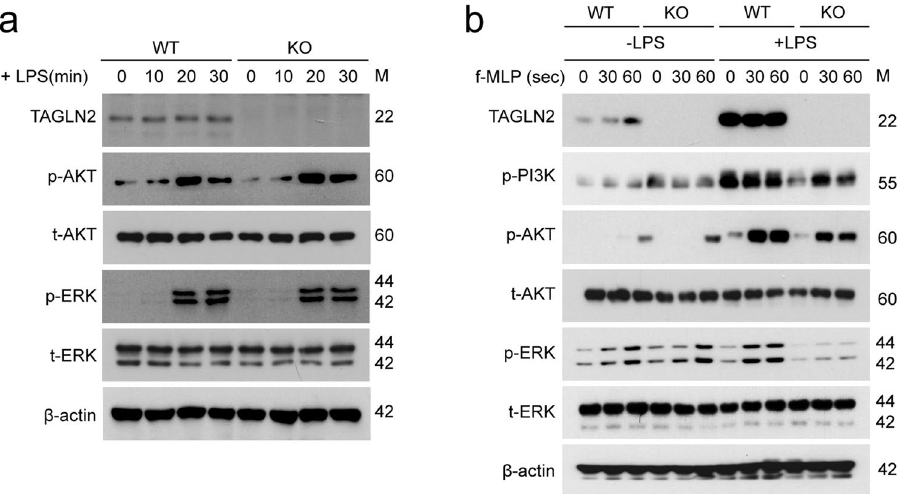
Figure 5. TAGLN2 is required for the activation of PI3 kinase/AKT and Ras-ERK signaling pathways. ( a ) Peritoneal macrophages from wild-type and TAGLN2 − / − mice were stimulated with LPS (1 μ g/mL) for the indicated time points. The phosphorylated and total forms of AKT, ERK, and JNK were detected by western blot. ( b ) Peritoneal macrophages were pre-activated with LPS (1 μ g/mL) for 24 h. Cells were serum-starved for 3 h and stimulated with fMLP (1 μ M) for the times indicated. Cell lysates were subjected to western blot with anti-phospho and total PI3K, AKT, ERK, and JNK. The data are representative of three independent experiments. Full-length blots/gels are presented in Supplementary Fig.